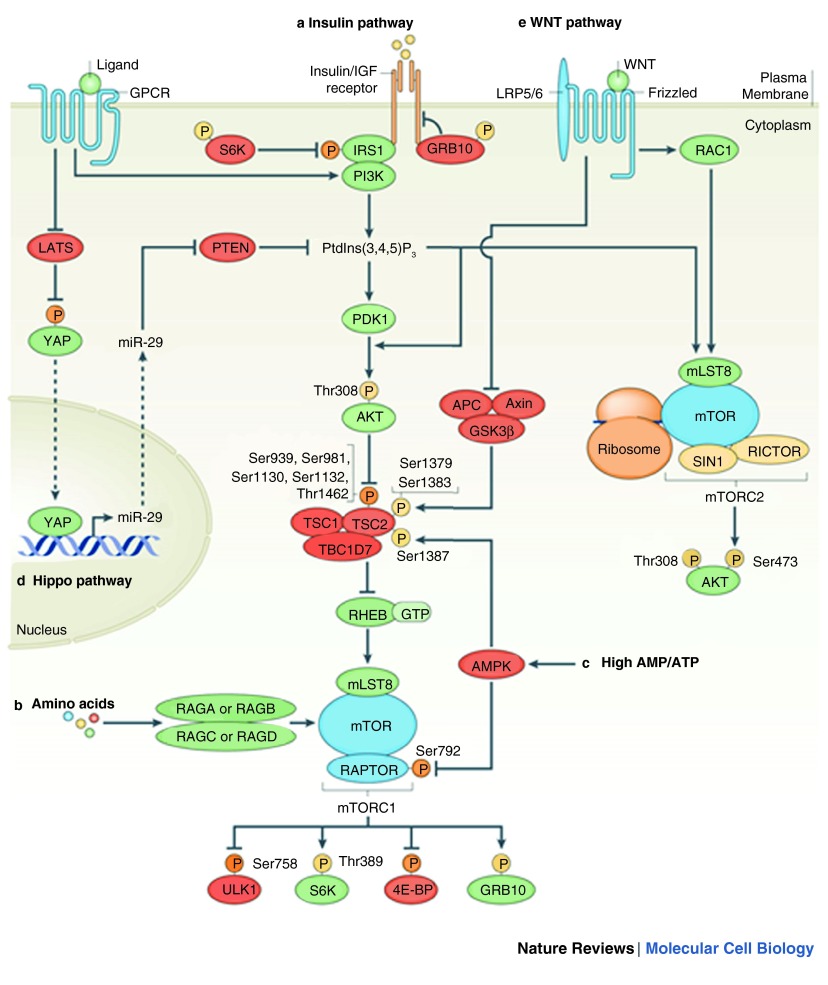
Upstream of mTOR: classical and non-classical inputs.
a | Growth factors such as insulin stimulate PI3K to generate phosphatidylinositol-3,4,5-triphosphate (PtdIns(3,4,5)P
3), which promotes the phosphorylation (P) of AKT at Thr308 by phosphoinositide-dependent kinase 1 (PDK1). AKT phosphorylates tuberous sclerosis complex 2 (TSC2) on multiple sites to inhibit its GTPase-activating protein (GAP) activity for the small GTPase RAS homologue enriched in brain (RHEB). GTP-loaded RHEB then activates mammalian TOR complex 1 (mTORC1). Growth factors also stimulate mTORC2 by promoting its association with ribosomes in a PI3K-dependent manner.
b | Amino acids stimulate mTORC1 by promoting the conversion of RAS-related GTP-binding protein (RAG) heterodimers to the active conformation, in which RAGA or RAGB is loaded with GTP and RAGC or RAGD is loaded with GDP.
c | In response to low energy (high AMP/ATP ratio), AMP-activated protein kinase (AMPK) phosphorylates regulatory-associated protein of mTOR (RAPTOR) at Ser792 and TSC2 at Ser1387, leading to the inhibition of mTORC1.
d | During the inhibition of the Hippo pathway component large tumour suppressor homologue (LATS) kinase, hypophosphorylated Yes-associated protein (YAP) translocates to the nucleus and promotes the expression of the microRNA miR-29. miR-29 targets PTEN mRNA and inhibits PTEN translation, which leads to increased levels of PtdIns(3,4,5)P
3 and the activation of both mTORC1 and mTORC2. Dashed arrows represent translocation of the molecule.
e | Glycogen synthase kinase 3β (GSK3β) activates the TSC complex by phosphorylating TSC2 at Ser1379 and Ser1383. Phosphorylation of these two residues requires priming by AMPK-dependent phosphorylation of Ser1387. WNT signalling inhibits GSK3β and the TSC complex, and thus activates mTORC1. mTORC2 is activated by WNT in a manner dependent on the small GTPase RAC1. Proteins shown in green promote mTOR activity or their activity is promoted by mTOR. Proteins shown in red inhibit mTOR activity or their activity is inhibited by mTOR. Phosphorylation depicted in yellow is an activation signal and phosphorylation depicted in orange is an inhibitory signal. 4E-BP, eIF4E-binding protein; APC, adenomatous polyposis coli; GPCR, G protein-coupled receptor; GRB10, growth factor receptor-bound protein 10; IGF, insulin-like growth factor 1;IRS1, insulin receptor substrate 1; LRP, low-density lipoprotein receptor-related protein; mLST8, mammalian lethal with SEC thirteen 8; RICTOR, rapamycin-insensitive companion of mTOR; S6K, ribosomal S6 kinase; SIN1, SAPK-interacting 1; TBC1D7, TBC1 (TRE2–BUB2–CDC16) domain family member 7; ULK1, UNC-51-like kinase 1.This figure has been reproduced with kind permission from Shimobayashi M, Hall M. Making new contacts: the mTOR network in metabolism and signalling crosstalk. Nature Reviews Molecular Cell Biology 2014;15:155–162.